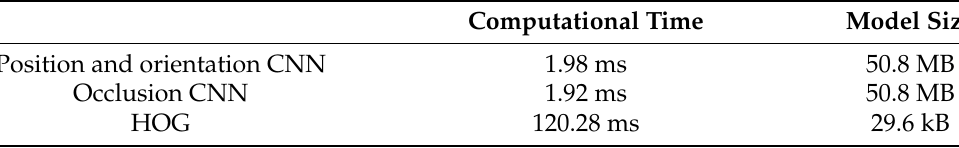
Table 1. Requirements on individual neural